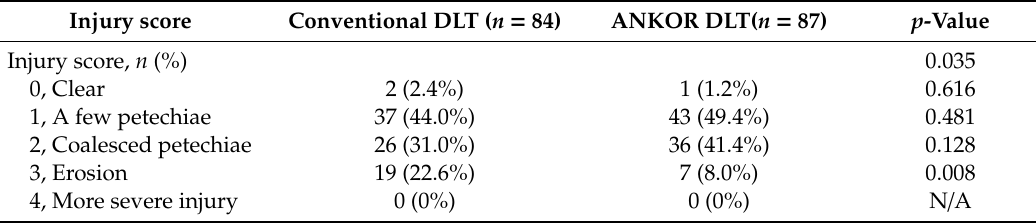
Table 3. The injury of tracheobronchial tree after initial DLT placement into the left mainstem bronchus. Injury